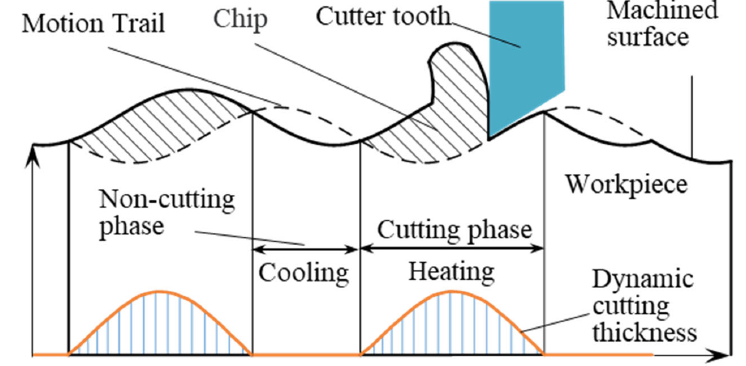
Figure 2. Schematic diagram of the vibratory cutting process.